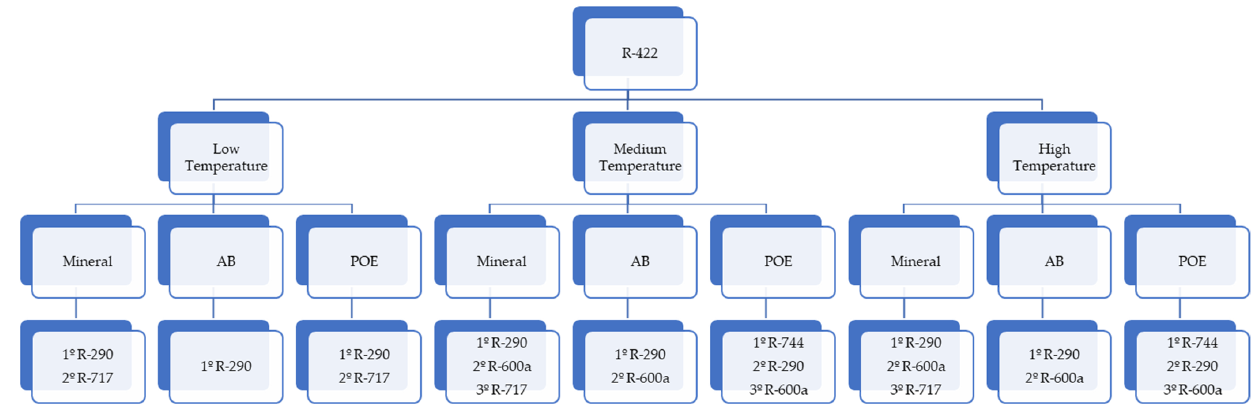
Figure 7. Decision tree for R-422 refrigerant replacement possibilities.